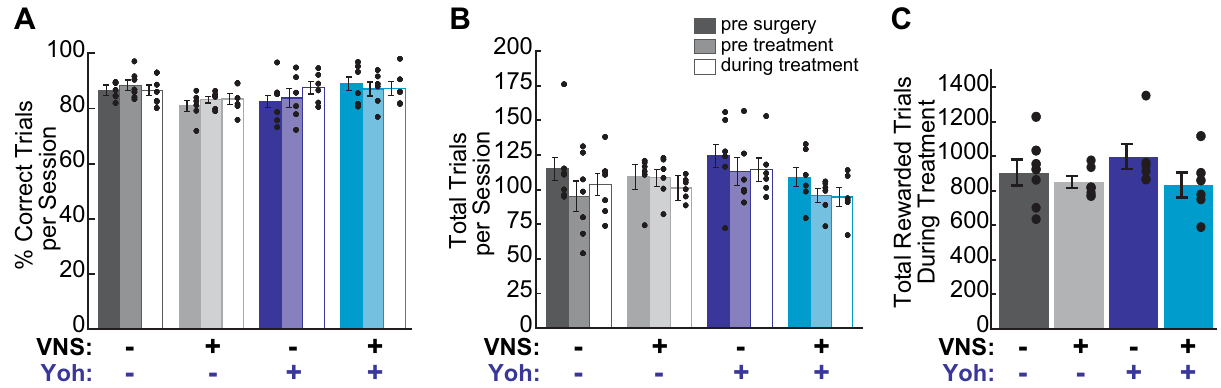
Figure 4. Differences in behavioral performance or VNS exposure cannot explain mapping results. ( A ) There was no difference across groups in average percent correct performance prior to surgery, before treatment, or during the ten treatment sessions, nor did treatment impact percent correct performance in any group. ( B ) No difference was observed across treatment groups in the average number of training trials performed per session during any epoch, nor did treatment significantly impact the number of trials performed within any treatment group. ( C ) The total number of rewarded trials did not differ across treatment groups during the Treatment period, indicating that VNS treated rats in both yohimbine- and vehicle-infused groups received equivalent exposure to VNS. Filled circles denote data for individual subjects; error bars denote